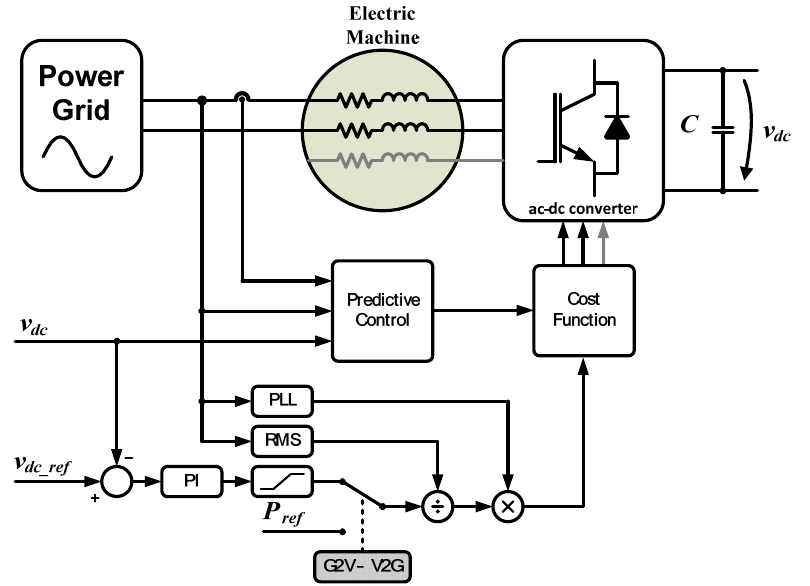
Figure 13. Block diagram of the implemented control system for the slow battery-charging mode.